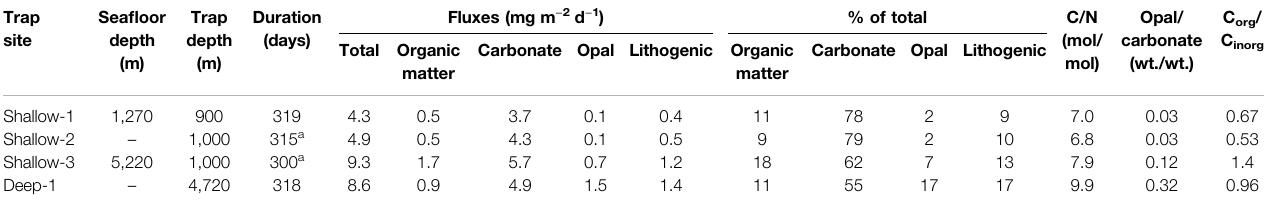
TABLE 1 | Mean fl uxes, average compositions, and ratios (C/N, opal/carbonate, and C org /C inorg ) of sinking particles collected at JA06 seamount. Trap site